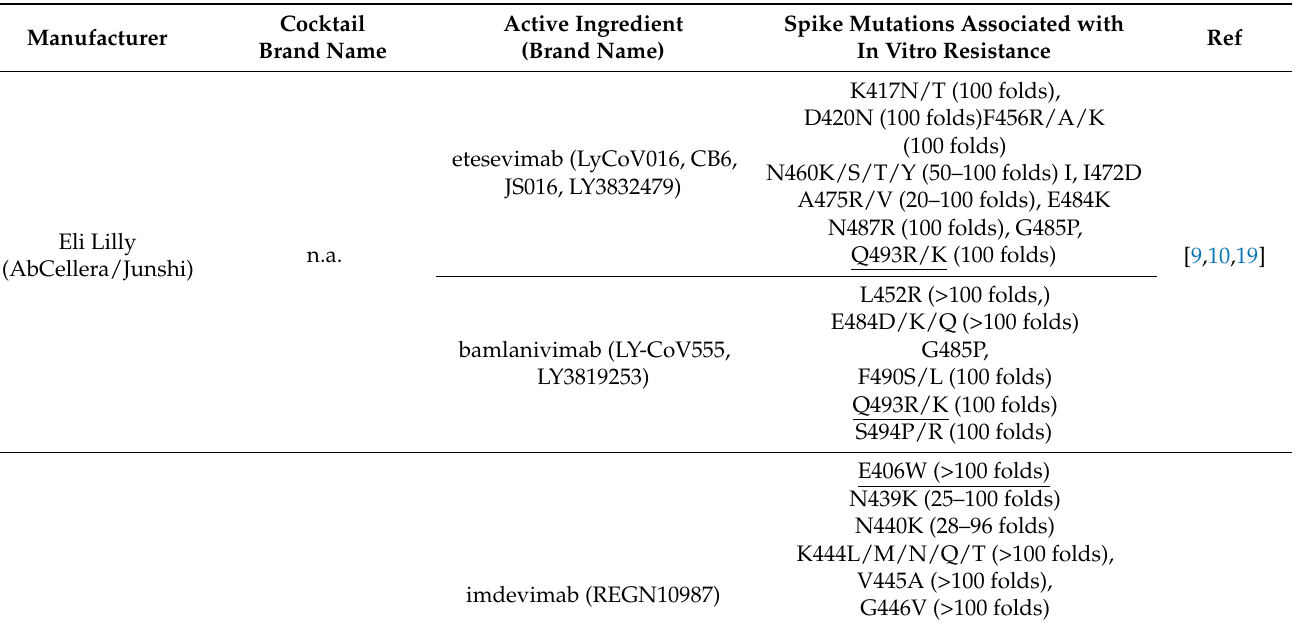
Table 1. Spike mutations associated with clinically-approved mAb resistance in vitro, sourced via the Stanford University Coronavirus Antiviral and Resistance Database (accessed online on 13 December 2021, at https://covdb.stanford.edu/search-drdb/). Mutations conferring resistance to both mAbs within the cocktail are